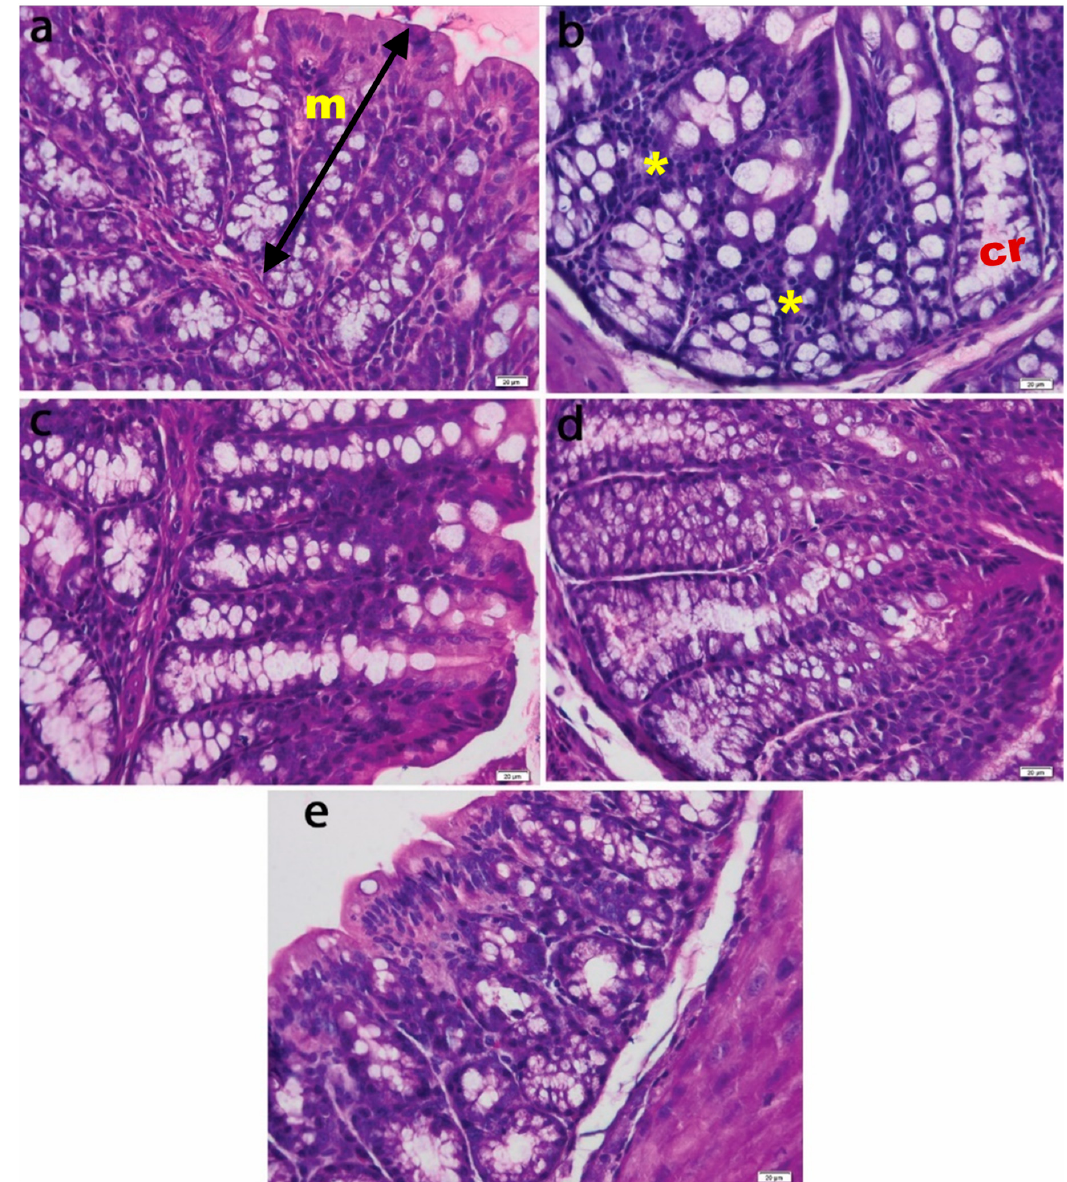
Figure 4. Histological appearance of intestinal mucosa in experimental groups: ( a ) Control; ( b ) 2,4,6-trinitrobenzenesulfonic acid (TNBS); ( c ) TNBS + 5 mg Thuja occidentalis MT/kg of body weight; ( d ) TNBS + 25 mg Thuja occidentalis MT/kg of body weight; ( e ) TNBS + 50 mg Thuja occidentalis MT/kg of body weight. Note: mucosa (m), crypt (cr), and inflammatory cells (*). Hematoxylin and eosin (H&E) staining 20×.